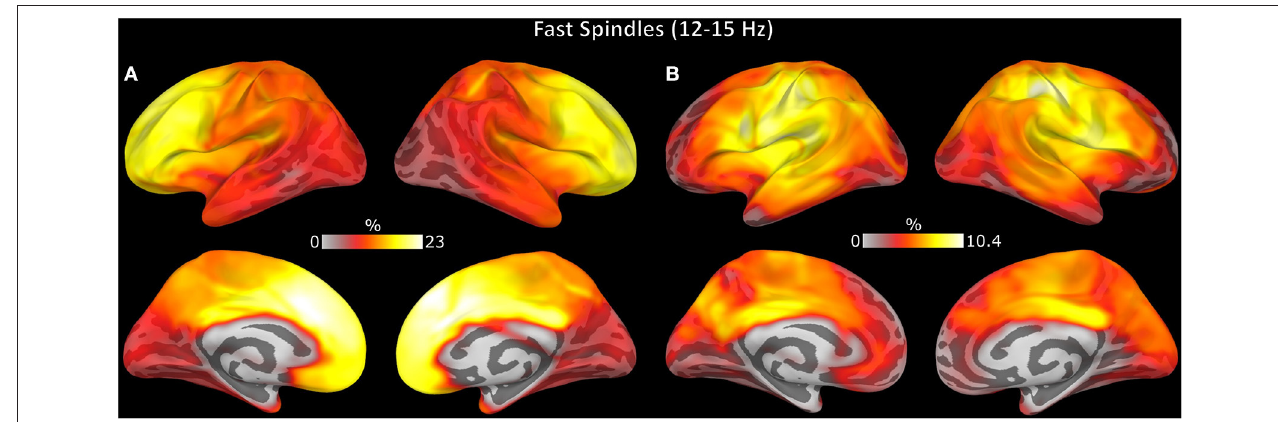
FIGURE 7 | Topography of spindle events uniquely detected by (A) EEG and (B) MEG. The color represents the percent of spindle events detected in each region relative to the total spindle events